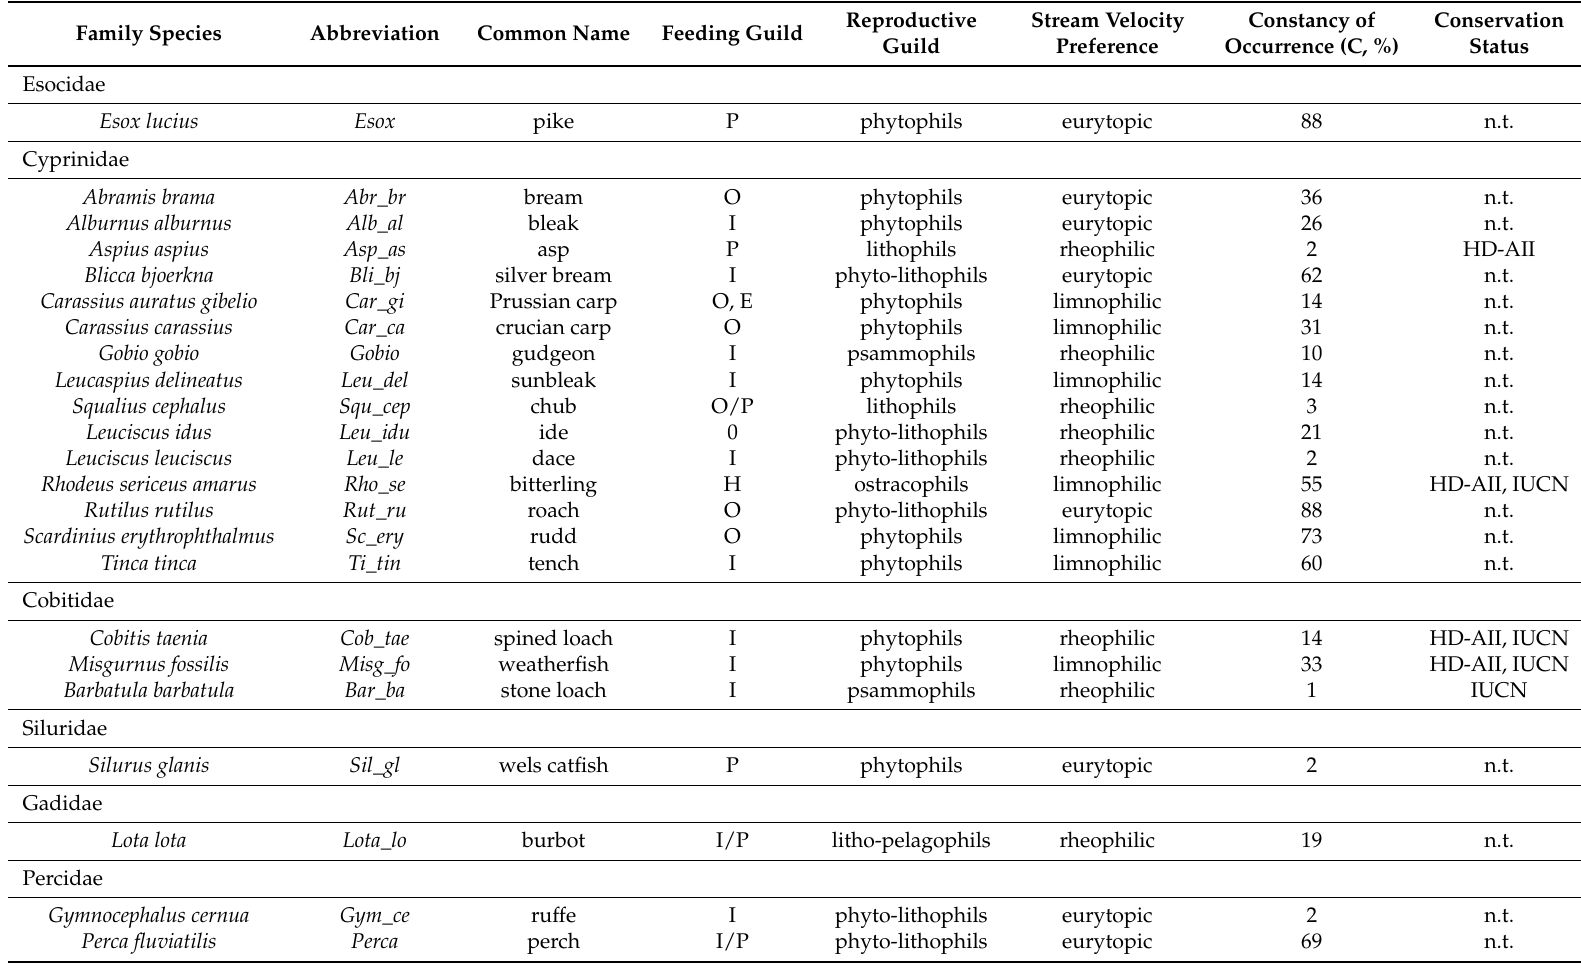
Table 3. Ecological guilds of fish in the studied floodplain lakes of the Biebrza River. Denotations: I, invertivore; O, omnivore; P, piscivore; H, herbivore; E, exotic species, N, number of specimens caught; HD-AII, annex II of EU Habitat Directive; IUCN, IUCN Red List of Threatened Species; n.t., not threatened